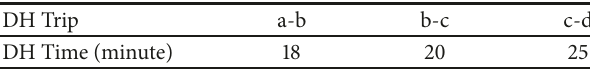
Table 4: Average DH travel time (minutes) matrix.